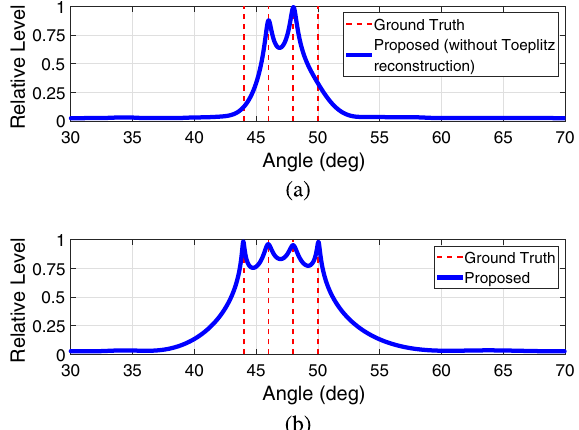
Fig. 8 Estimation performance of the proposed algorithm for targets at identical distance. a Proposed algorithm without Toeplitz reconstruction; b Proposed algorithm with Toeplitz reconstruction